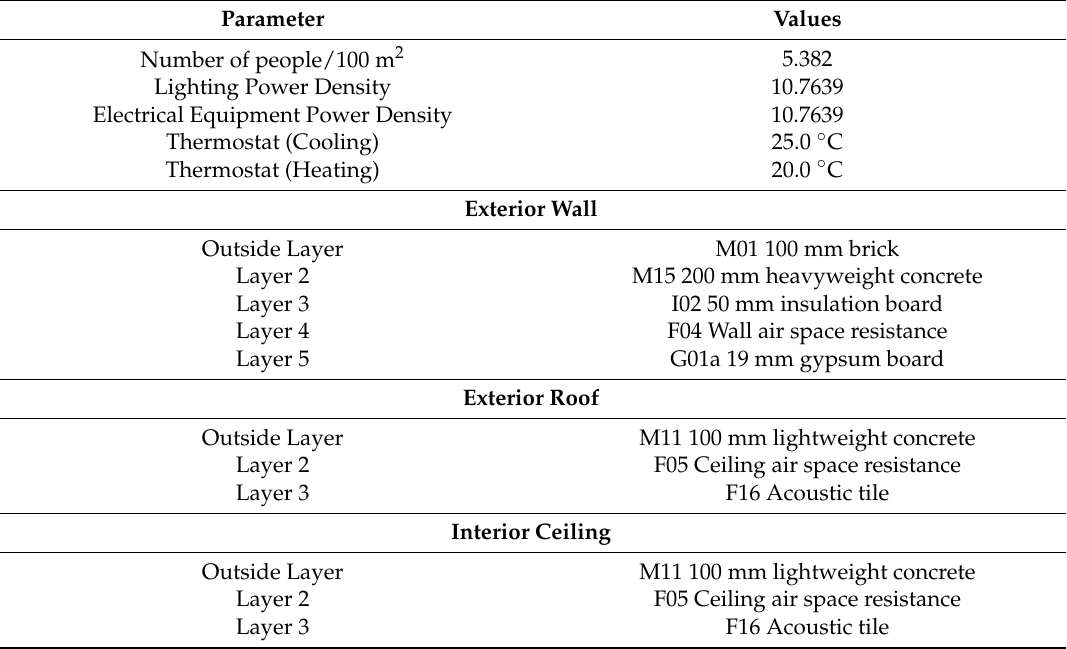
Table 2. Parameters for Building Energy simulation in